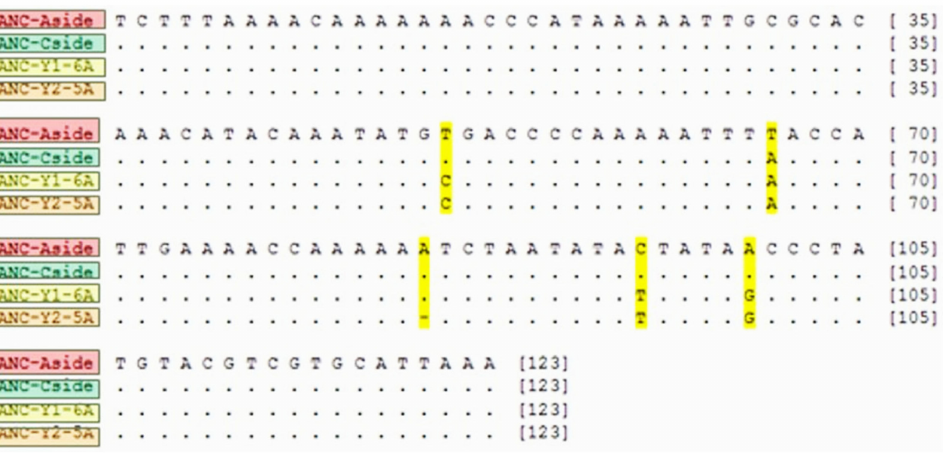
Figure 2. Differences between the four haplotypes described for Romanian